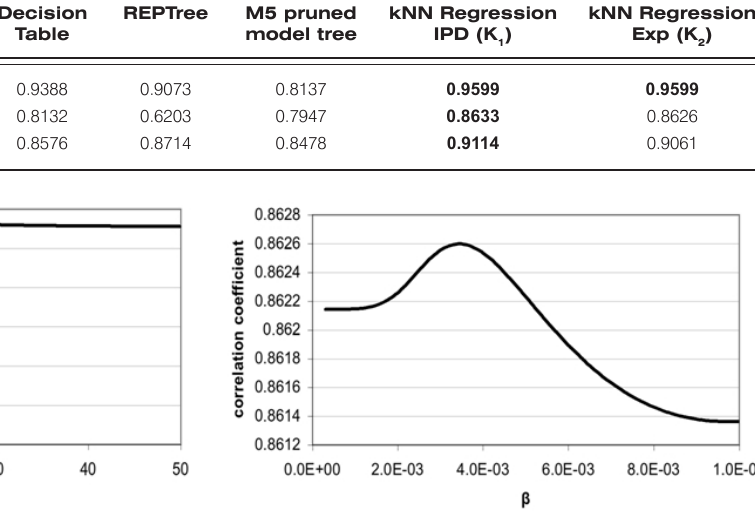
Figure 8. The correlation coefficient for the test set as a function of α.